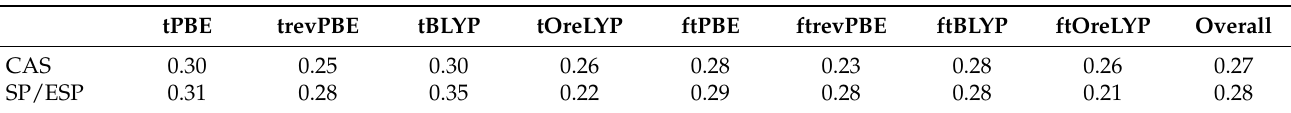
Table 12. The mean unsigned errors (eV) of ground state bond dissociation energies of transition metal diatomics as computed with CAS-PDFT and SP-PDFT/ESP-PDFT with various on-top pair-density functionals. tPBE trevPBE tBLYP tOreLYP ftPBE ftrevPBE ftOreLYP